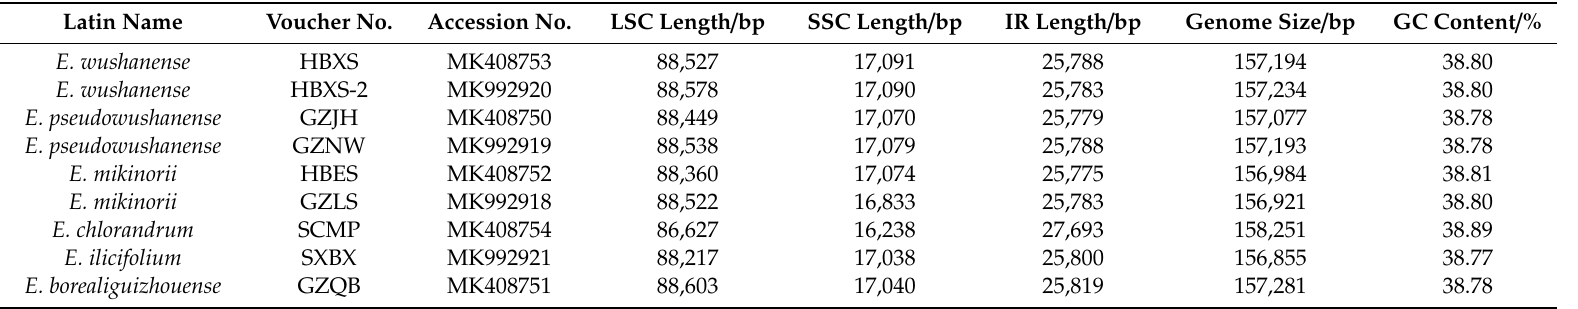
Table 1. Plastid genome characteristics of E. wushanense and its closely related